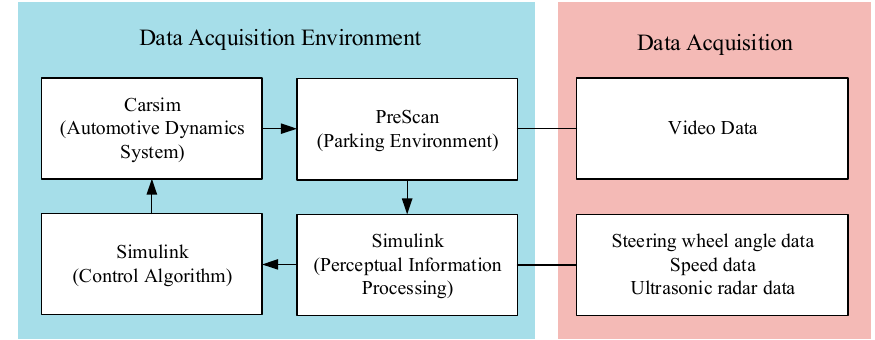
Figure 3. Simulation data acquisition fl owchart.